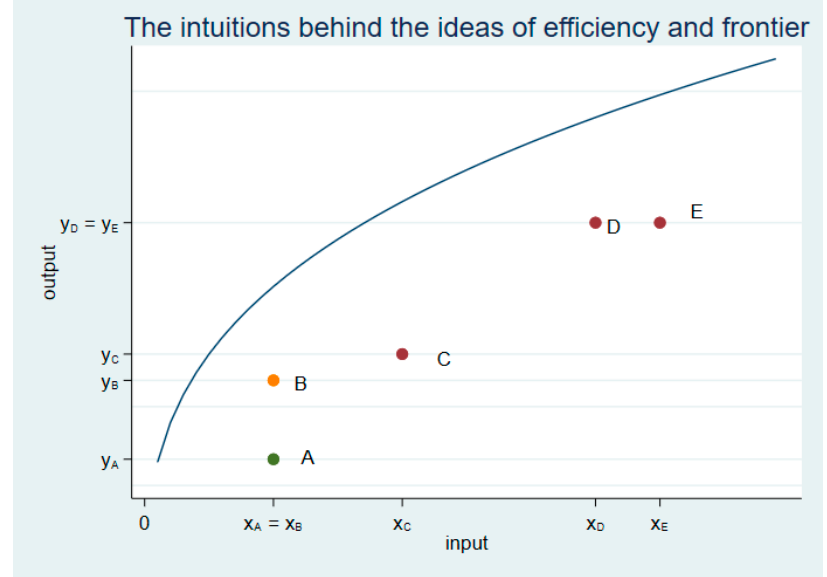
Figure 1. The intuitions behind the ideas of efficiency and frontier. Note: The figure portrays the ideas of efficiency and frontier. x is input and y is output. The concave solid line represents the technology or frontier of possibilities of production, the maximum attainable amount of output for each value of the input endowment. The dots A, B, C, D and E represent decision-making units or DMUs, i.e., firms, organizations, institutions, etc., whose efficiency is considered. Intuitively, B is more efficient than A because it produces more output than A (y B > Y A ) with the same amount of input (x B = x A ). Similarly, D is more efficient than E since D uses a smaller amount of input (x D < X E ) to produce the same amount of output (Y D = Y E ). The closer a DMU is to the frontier, the larger its level of efficiency. Source: own elaboration.